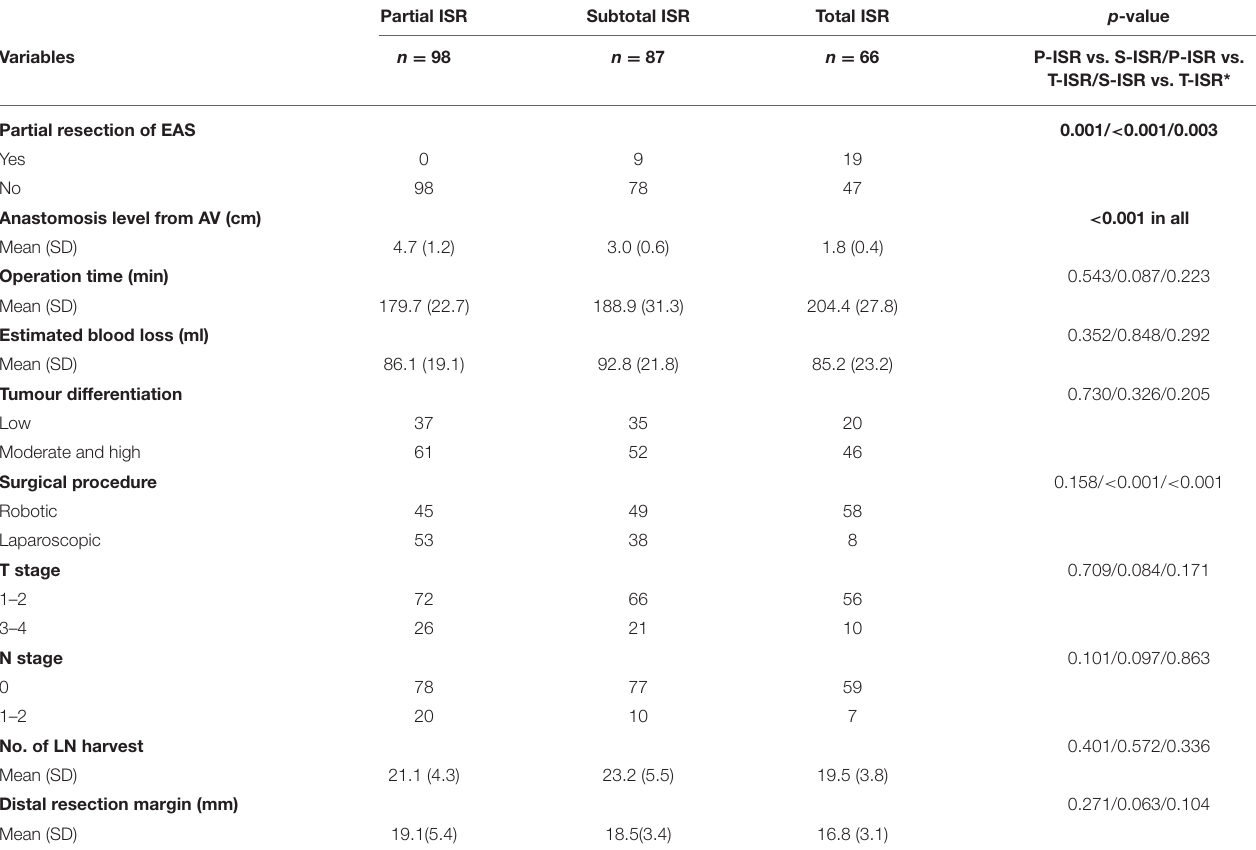
TABLE 2 | Operative features and pathological characteristics in patients. Partial ISR Subtotal ISR Total ISR p -value Variables n = 98 n = 87 n = 66 P-ISR vs. S-ISR/P-ISR vs. T-ISR/S-ISR vs.